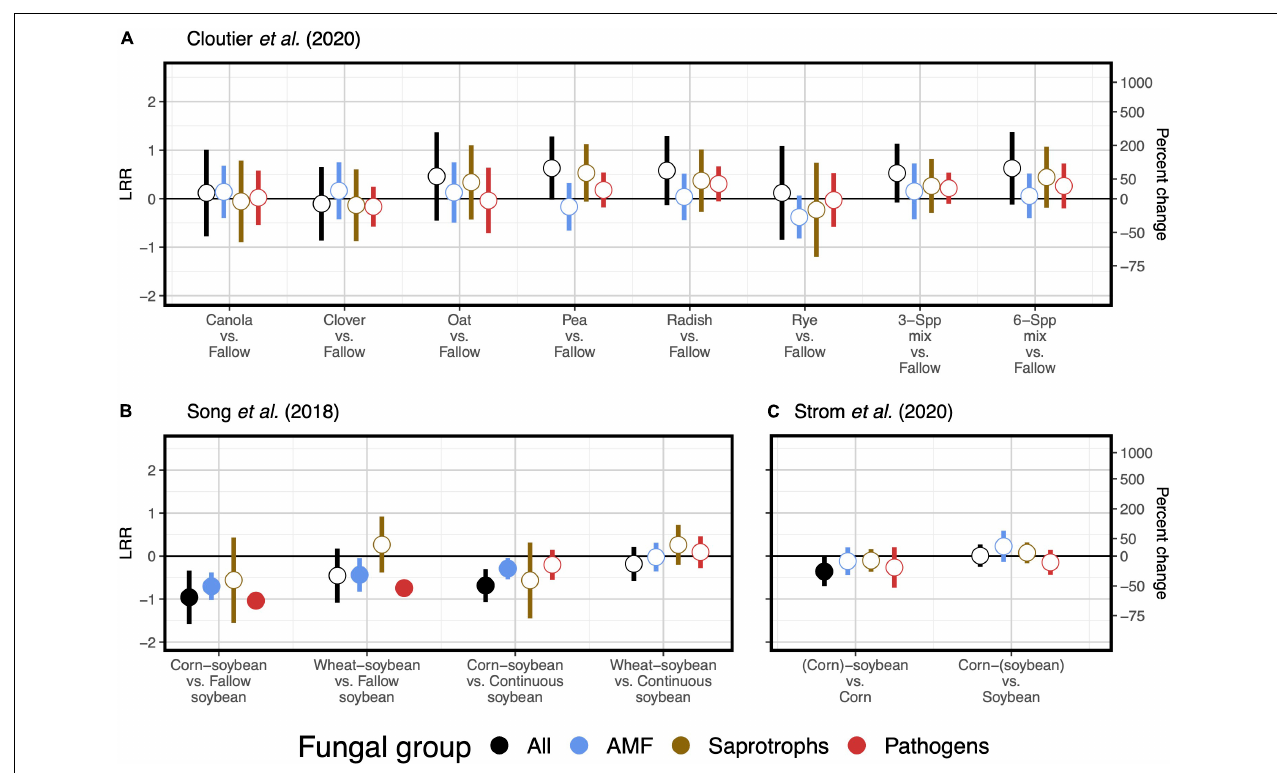
FIGURE 3 | Responses of soil fungal diversity to crop diversification. Responses are shown as log response ratios (LRR) with 95% confidence intervals which account for low sample sizes (Pustejovsky, 2018). Three studies are represented: Cloutier et al. (2020) (A) , Song et al. (2018) (B) , and Strom et al. (2020) (C) . Responses are calculated using Inverse Simpson diversity. While black responses represent the total fungal community, colored responses represent functionally distinct subsets of the fungal community: arbuscular mycorrhizal fungi (AMF; blue), saprotrophic fungi (brown), and plant pathogenic fungi (red). Open points represent log response ratios whose 95% confidence intervals overlap zero, while solid points represent log response ratios whose 95% confidence intervals do not overlap